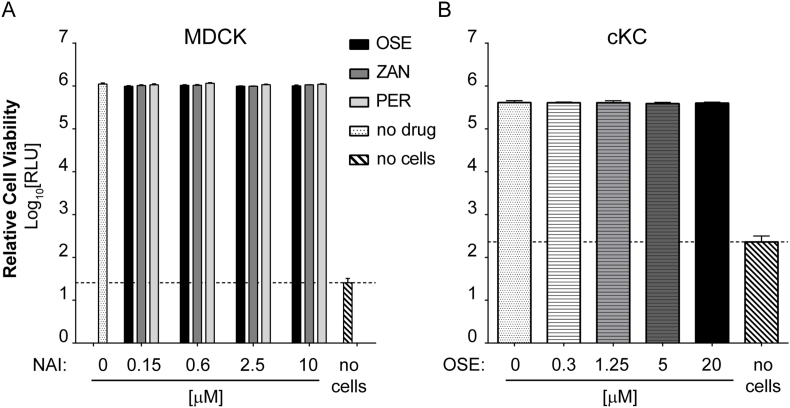
Cell viability of MDCK and cKC cultured in the presence of NAIs. MDCK (A) or cKC (B) cells were seeded in 96-well black-walled plates and cultured in the presence of NAI drugs for 72 h: (A) 0.15, 0.6, 2.5 or 10 μM of OSE (black bars), ZAN (grey bars) or PER (light grey bars); (B) 0.3, 1.25, 5 or 20 μM OSE, followed by cell viability assessment using luminescent assay (RLU). Untreated cells are shown as white dotted bar, and dashed line on the graph indicates background levels (no cells) also displayed by the white bar with diagonal stripes.